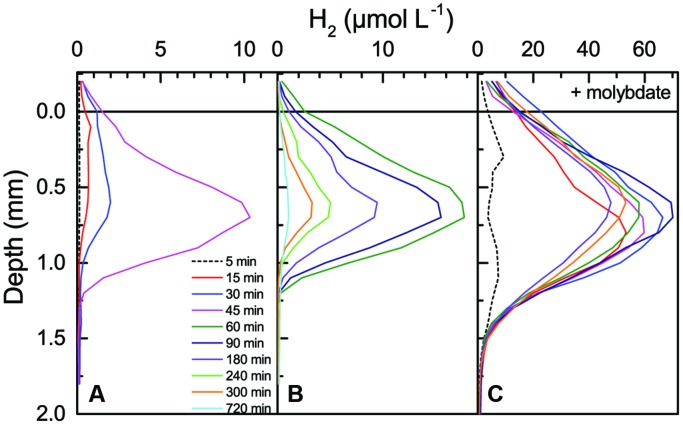
Accumulation and depletion of H2 in a coastal cyanobacterial mat as a function of time after darkening (see numbers and color legends in the graph). Prior to darkening, the mat was incubated under a photon irradiance of 500 μmol photons m-2 s-1 in aerated seawater for 8 h without (A,B) and for 6 h with 2.5 mM molybdate (C). Note the use of different concentration ranges in the different panels.